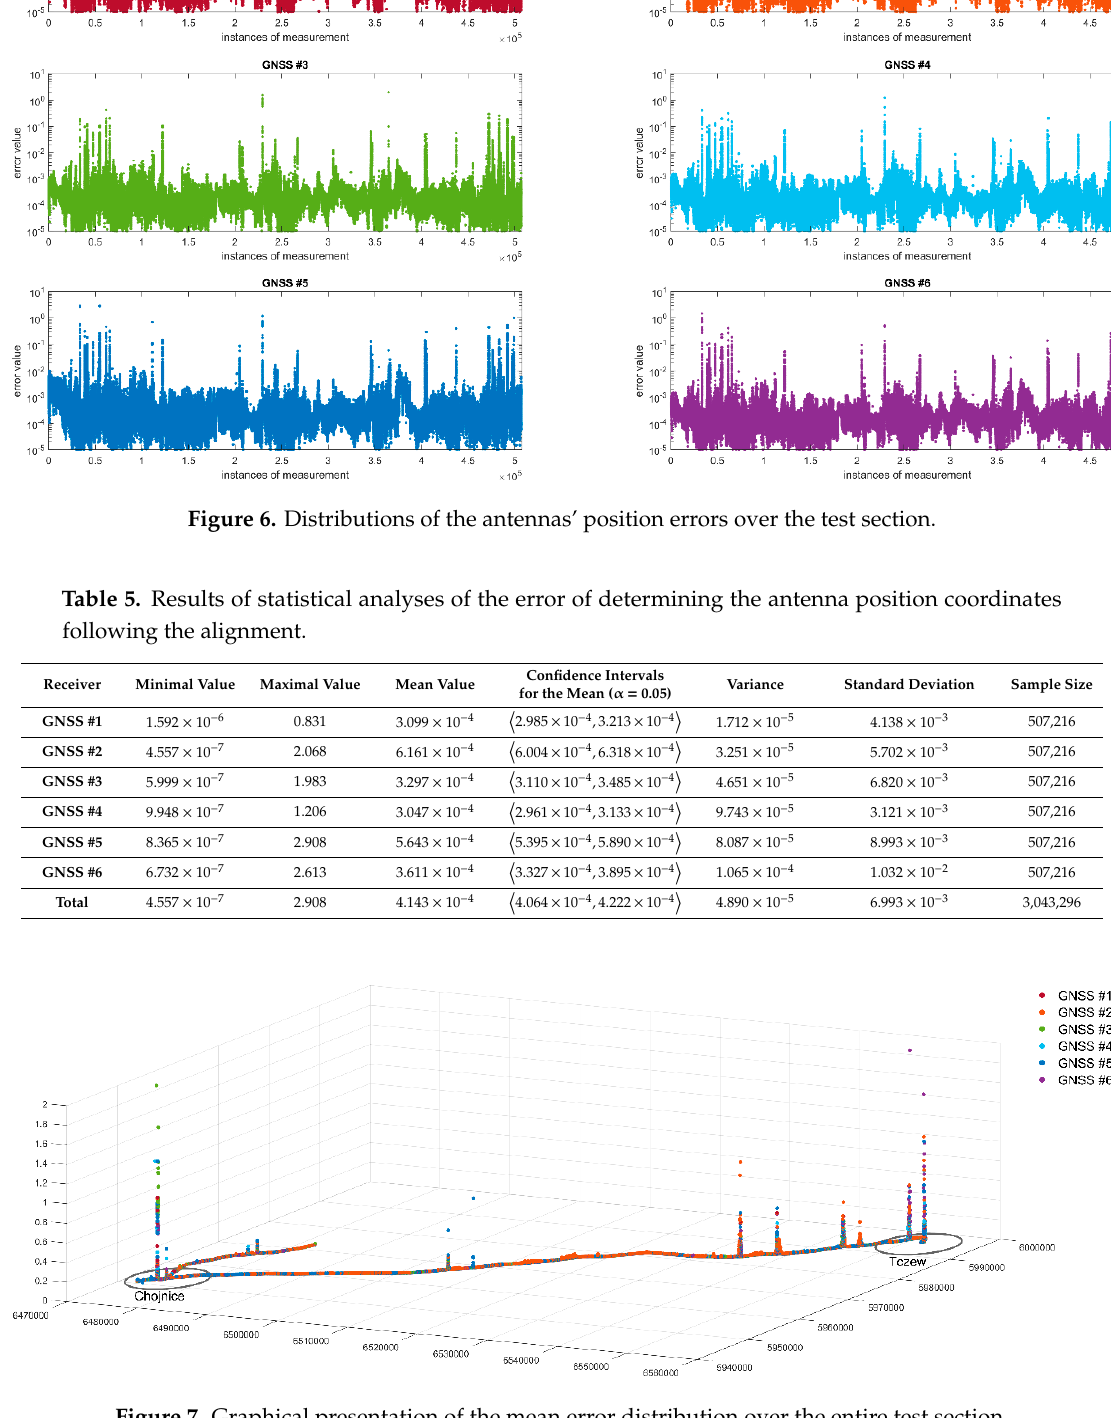
Figure 7. Graphical presentation of the mean error distribution over the entire test section.